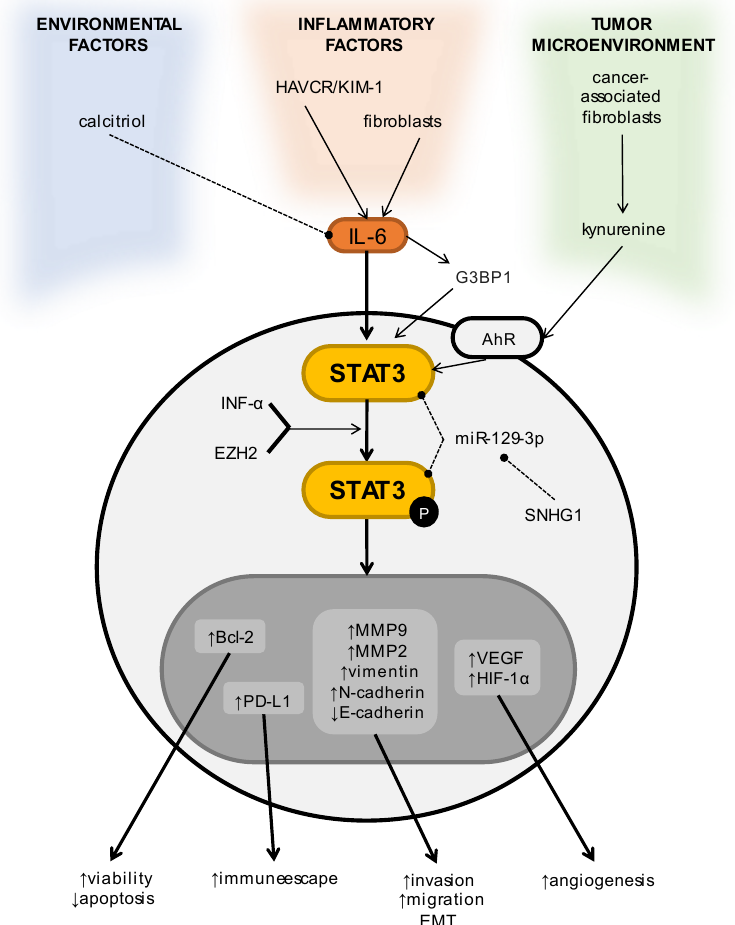
Figure 4. Schematic and simplified depiction of selected pathways and factors regulating STAT3 expression, counting its downstream target proteins, with the consequences of their overexpression in renal cell carcinoma. Dashed lines ending with a dot show inhibition; arrows show stimulation.